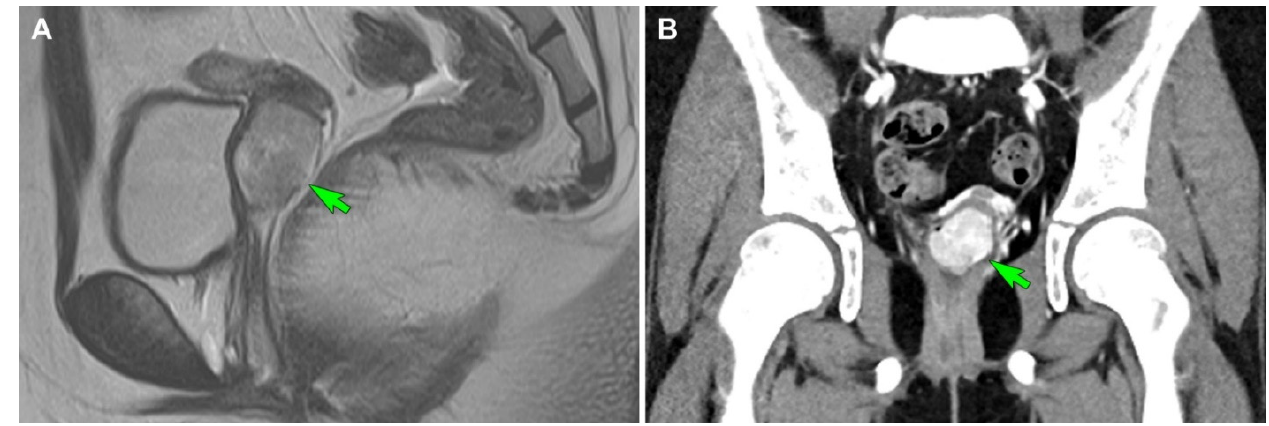
Figure 4. Imaging findings (case 2). ( A ) Initial T2-weighted turbo spin-echo sagittal magnetic resonance imaging reveals a well-circumscribed hypervascular mass (green arrow) originating in the uterine cervix, with heterogeneous high signal intensity and a lobulated contour. ( B ) Initial contrast-enhanced computed tomography shows an enhancing mass (green arrow) abutting the uterine cervix.